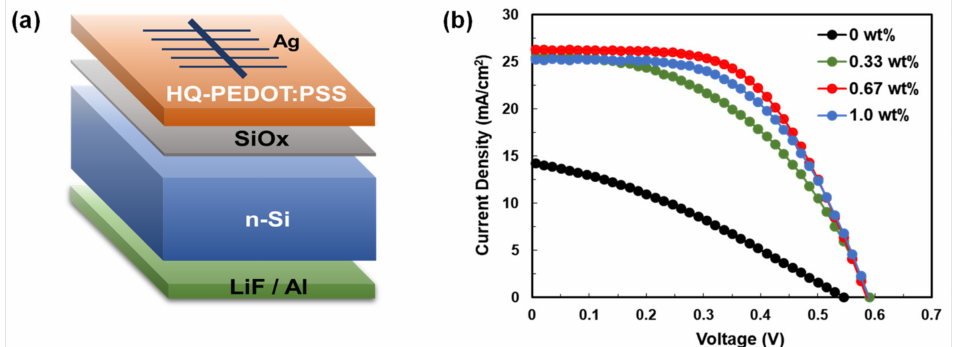
Figure 3. ( a ) Structure of the Si/HQ-PEDOT:PSS HSC and ( b ) current density vs. voltage characteris- tics of the various Si/HQ-PEDOT:PSS HSC samples with different HQ addition amounts. Table 1. Photovoltaic parameters of Si/PEDOT:PSS HSCs containing various amounts of HQ. Amount